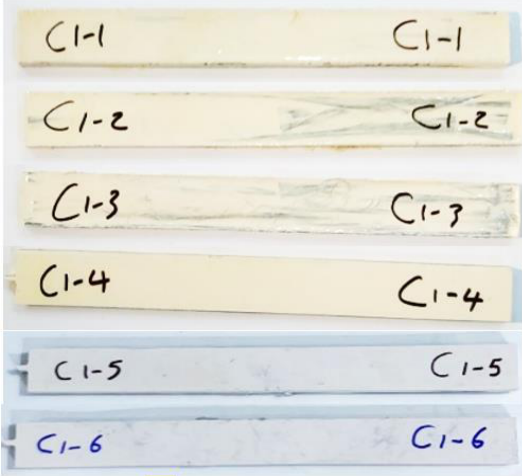
Fig. 7. Samples tested in flexural.